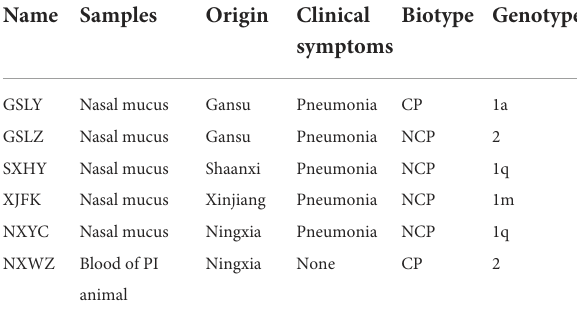
TABLE 3 Status of BVDV biotypes and genotypes in western